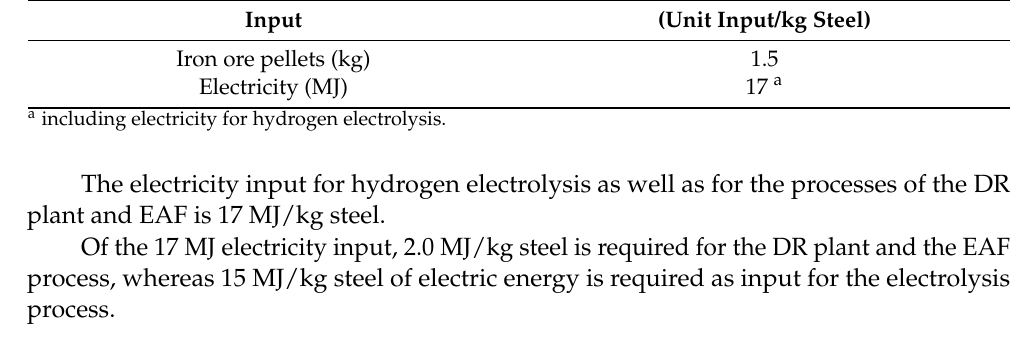
Table 6. Major inputs of the processes of electrolysis, hydrogen-based DR plant, and EAF. Input Iron ore pellets (kg) 1.5 Electricity